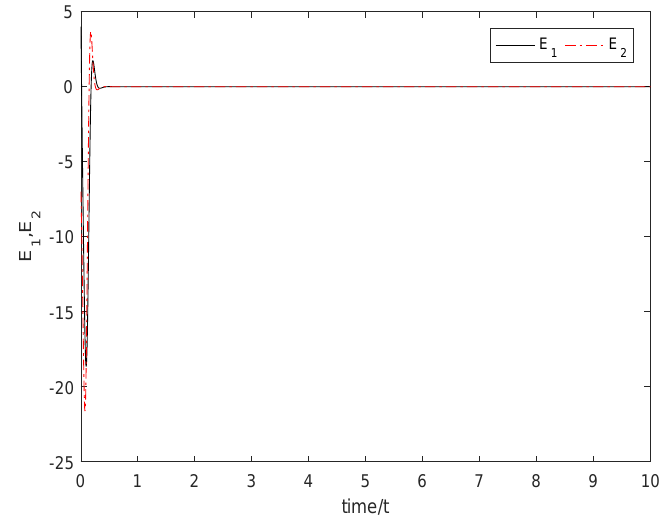
Figure 4. The sum subsystem (48) is asymptotically